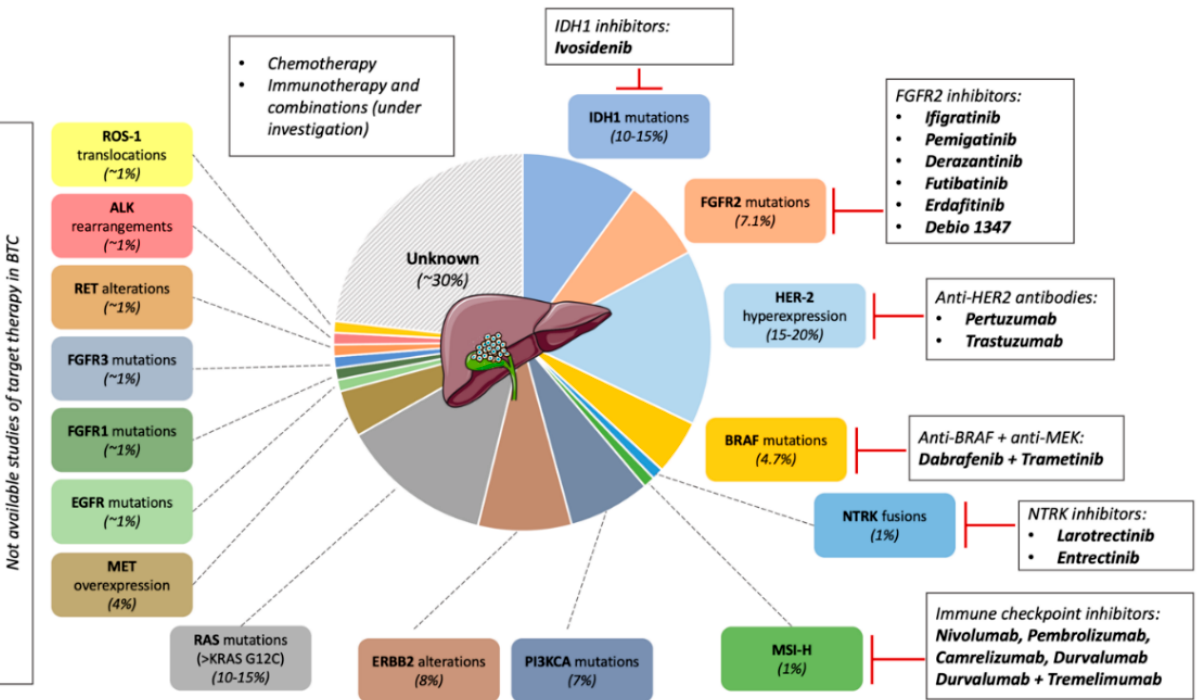
Figure 1. Molecular landscape of biliary tract cancer (BTC). Oncogenic alterations are found in approximately half of the patients diagnosed with biliary tract cancer. So far, only half of the pathways are targetable, with specific inhibitors tested in clinical trials: isocitrate dehydrogenase (IDH)-1, fibroblast growth factor receptor (FGFR)-2, HER-2, BRAF, NTRK. Moreover, patients with microsatellite instable tumors (MSI-H) are prone to respond to immunotherapy. Therefore, for most patients, chemotherapy remains the standard of care; immunotherapy (as single agent or combination) is under investigation.